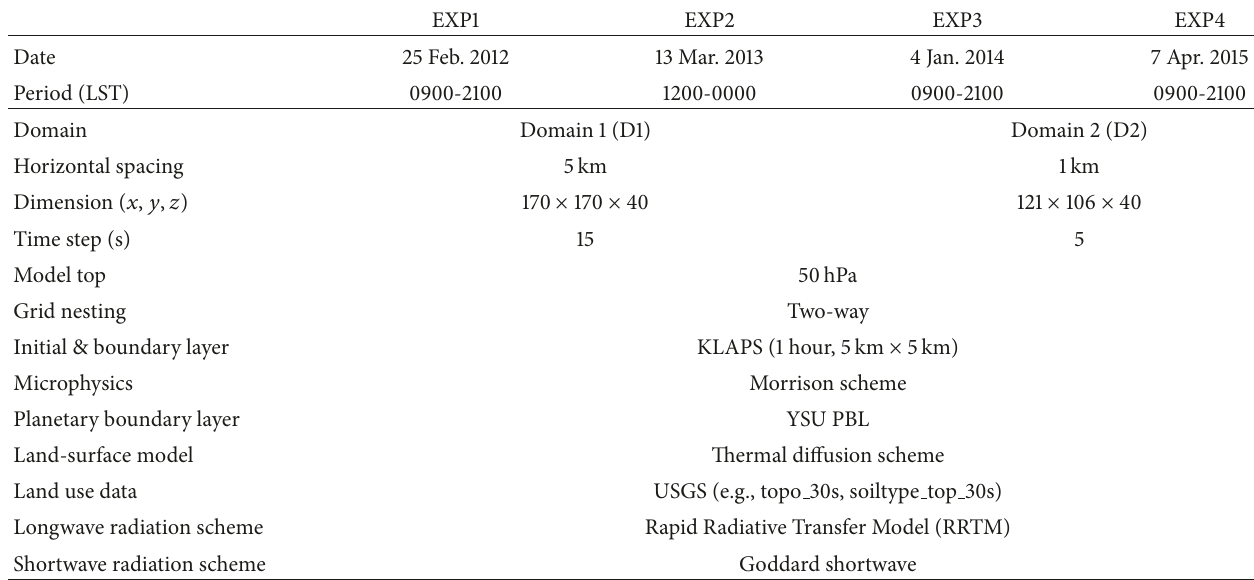
Table 2: Summary of model